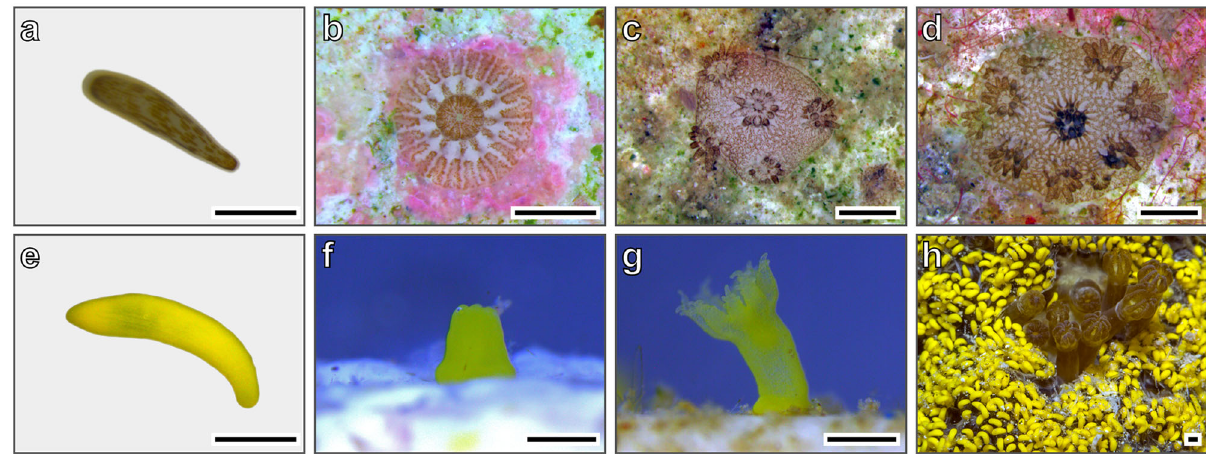
Fig. 4 Early life-history stages of the coral species studied. a Stylophora pistillata free-swimming larva. b A 2-day-old primary polyp of S. pistillata . c A 3-month-old S. pistillata originating from shallow-reef larva and translocated to the mesophotic depth. d A 3-month-old S. pistillata originating from shallow- reef larva and translocated to the shallow depth. e Rhytisma fulvum free-swimming larva. f Shortly after settlement, a R. fulvum larva metamorphosing into a